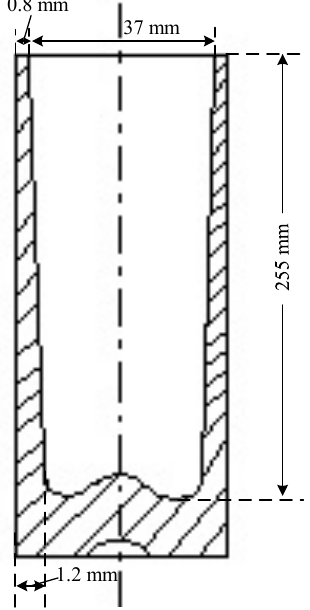
Figure 1. Structural sketch of a thin-walled tube.